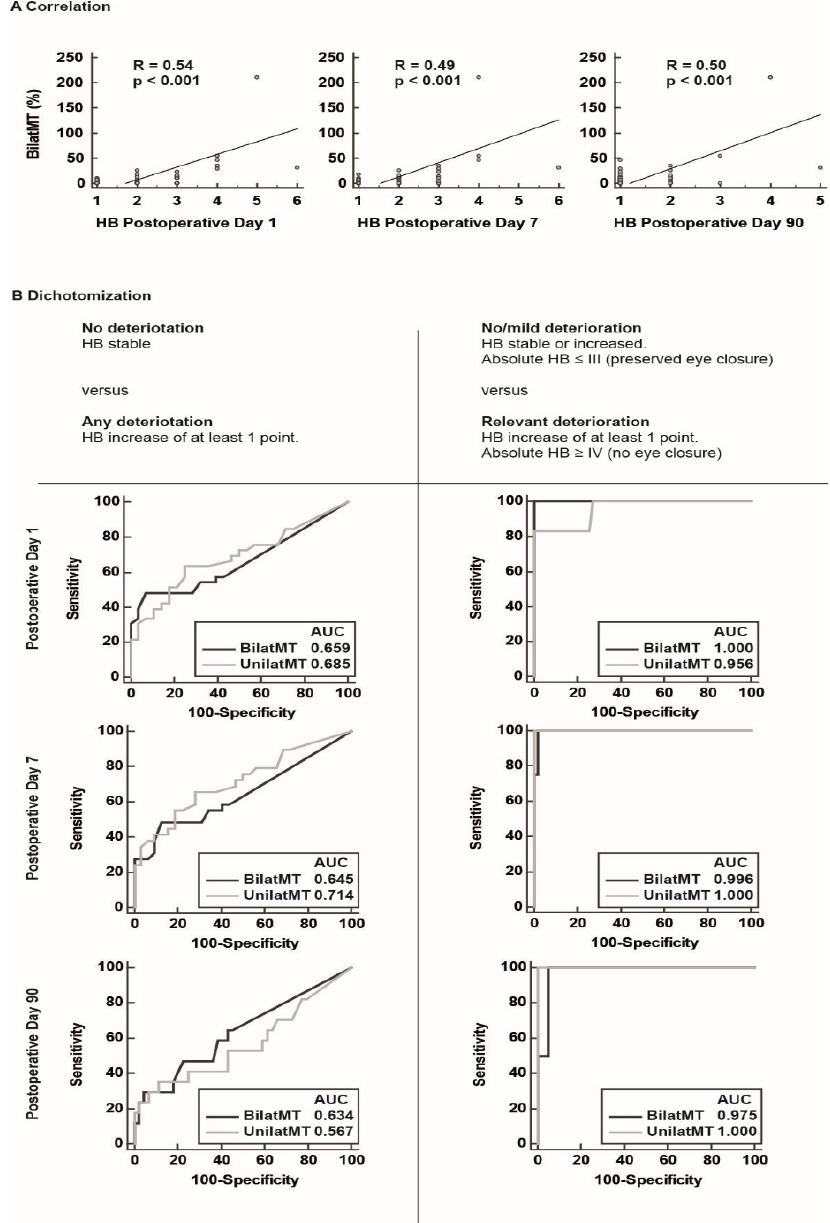
Figure 2. Correlation and ROC curve analysis ( A ) Correlation between change in ipsilateral versus contralateral difference in stimulation threshold increase to elicit FMcoMEPs (BilatMT) and absolute House–Brackmann (HB) score. The correlation was significant for all three time points. ( B ) Compar- ison of two forms of dichotomization for outcome measurement, for both BilatMT and ipsilateral stimulation threshold increase (UnilatMT). The area under the curve (AUC) was significantly higher for all time points for both BilatMT and UnilatMT.